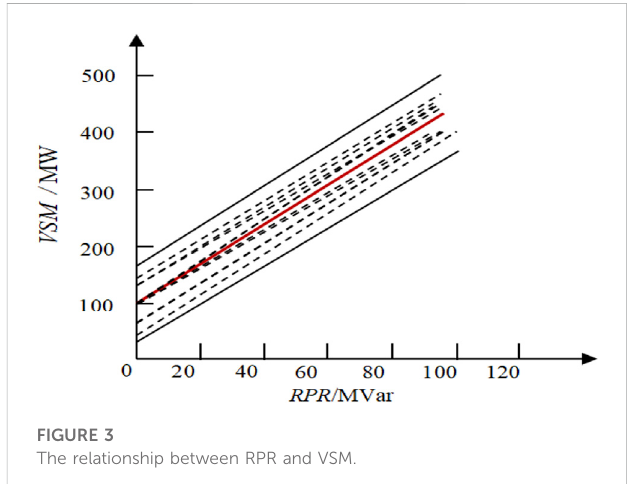
FIGURE 3 The relationship between RPR and